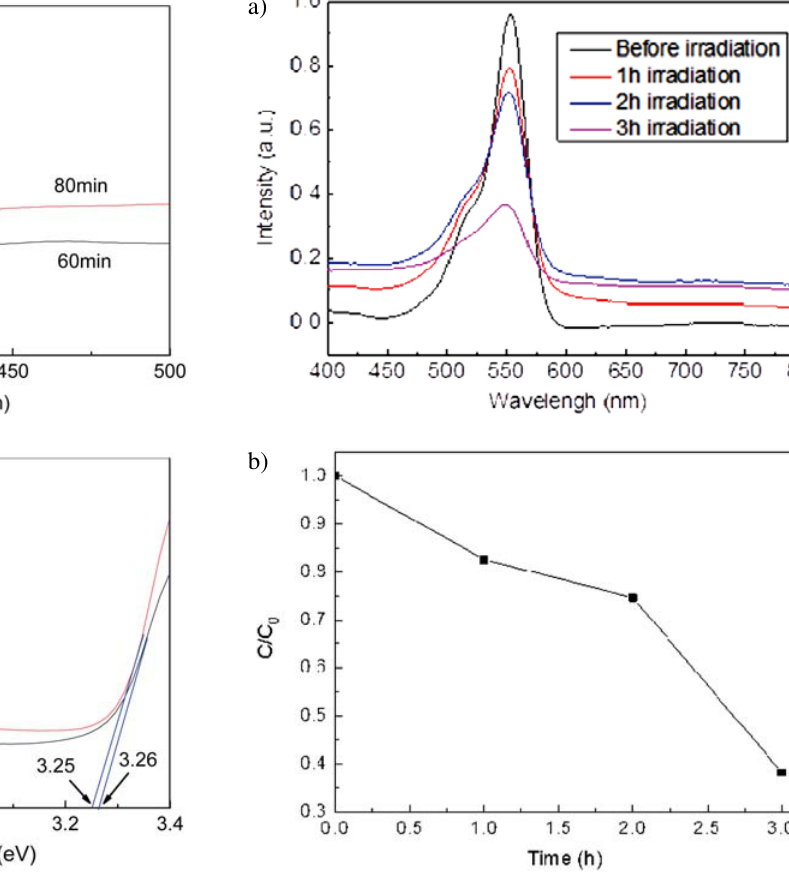
Fig.8. (a) Degradation of Rhodamine B with different irradiation ti- mes. (b) Degradation rate of Rhodamine B with ZnO